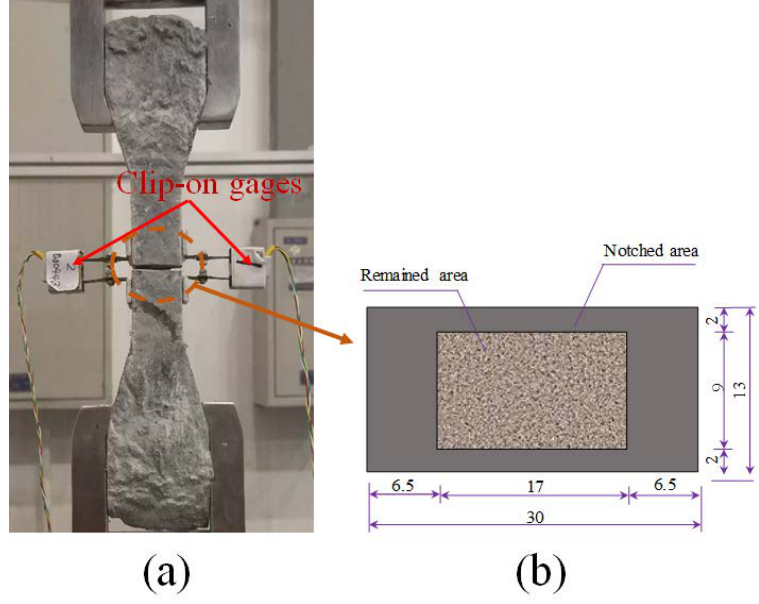
Figure 5. Single-crack tension test. ( a ) Instrumentation and ( b ) Notched dogbone specimen (unit: mm).